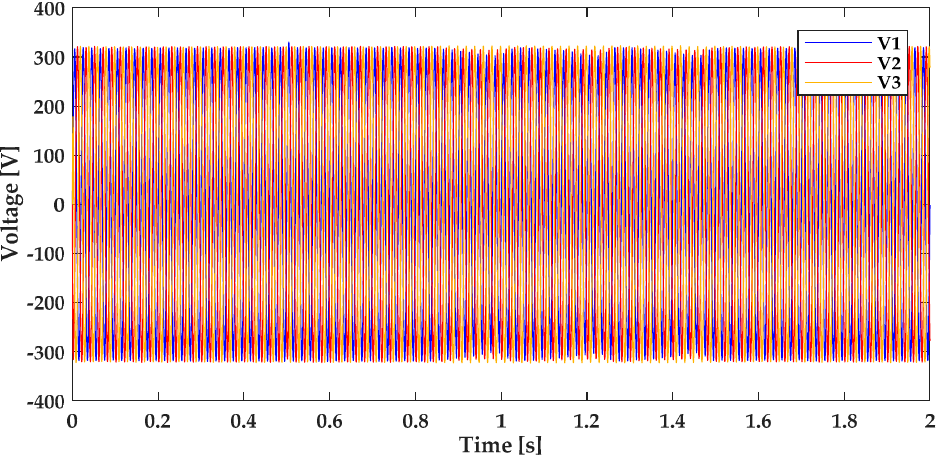
Figure 17. Voltage variation at the SST connection: stable operation.